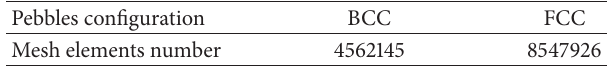
Table 3: Mesh number for BCC and FCC